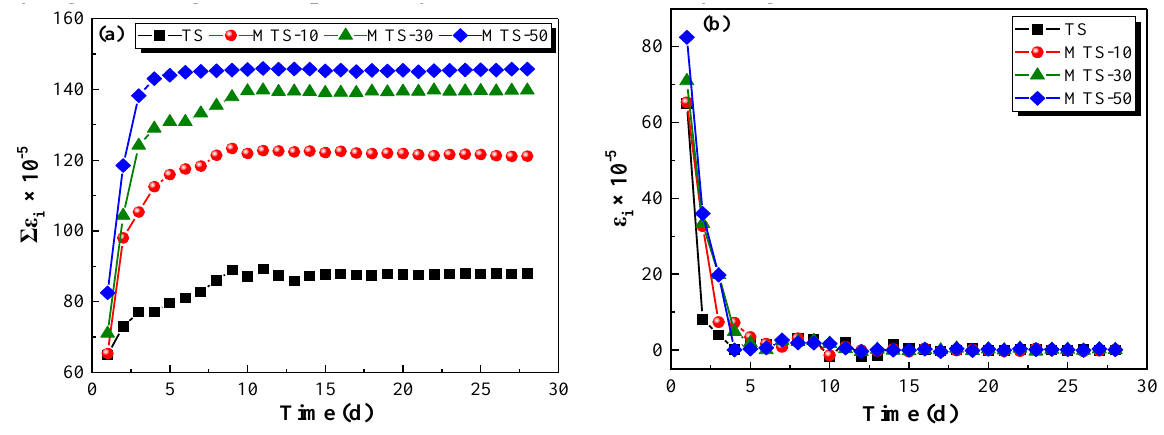
Figure 18. ( a ) Cumulative drying shrinkage strain ( Σ ε i ); ( b ) daily drying shrinkage strain ( ε i ).